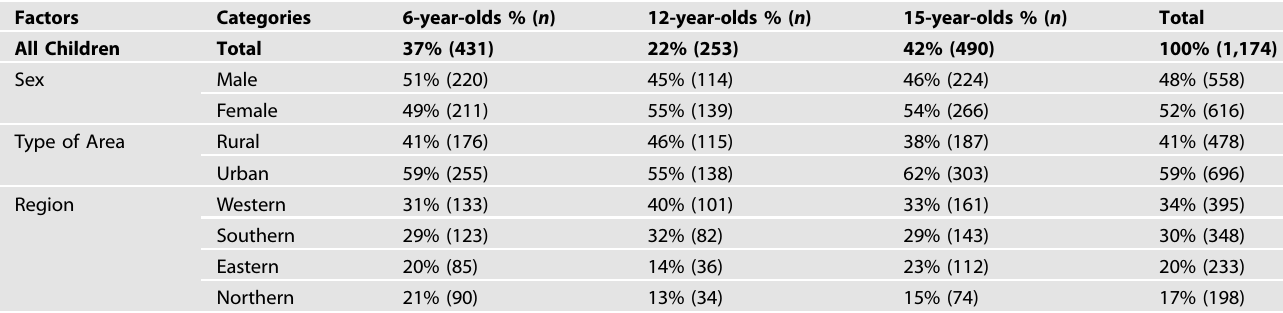
Table 1. Sierra Leone National Child Oral Health Survey participants, 2017 ( n =